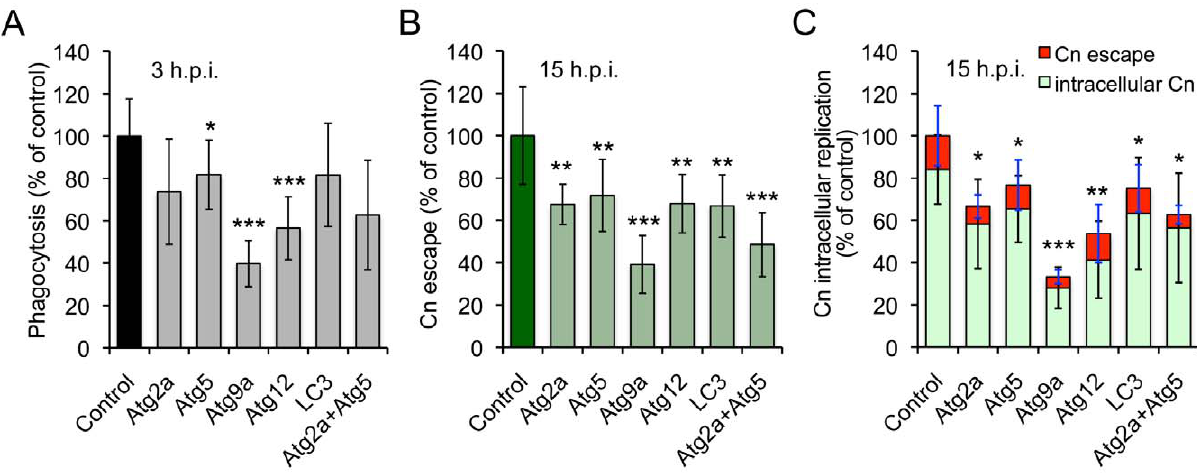
Figure 7. Host Atg proteins mediate Cryptococcusneoformans infection of host cells. Murine RAW264.7 macrophages were transfected with the indicated siRNAs (10 nM). Two days post-transfection, the host cells were infected with Cn (H99) for 3 hrs. The infected cells were extensively washed to remove the extracellular population of Cn cells, and fresh medium supplemented with 20 m g/ml fluconazole was added. At the indicated time points post infection, the supernatant and lysate from infected cells were collected separately. The materials were then plated, and the number of CFUs per well was determined. The resultant CFUs were used to calculate the relative phagocytosis ( A ), Cn escape ( B ) and intracellular replication ( C ) as described in the Materials and Methods . Data represent the means 6 SD from at least four independent experiments with triplicate wells examined for each treatment. *, **, *** indicates significance at p , 0.05, 0.01 and 0.001, respectively.